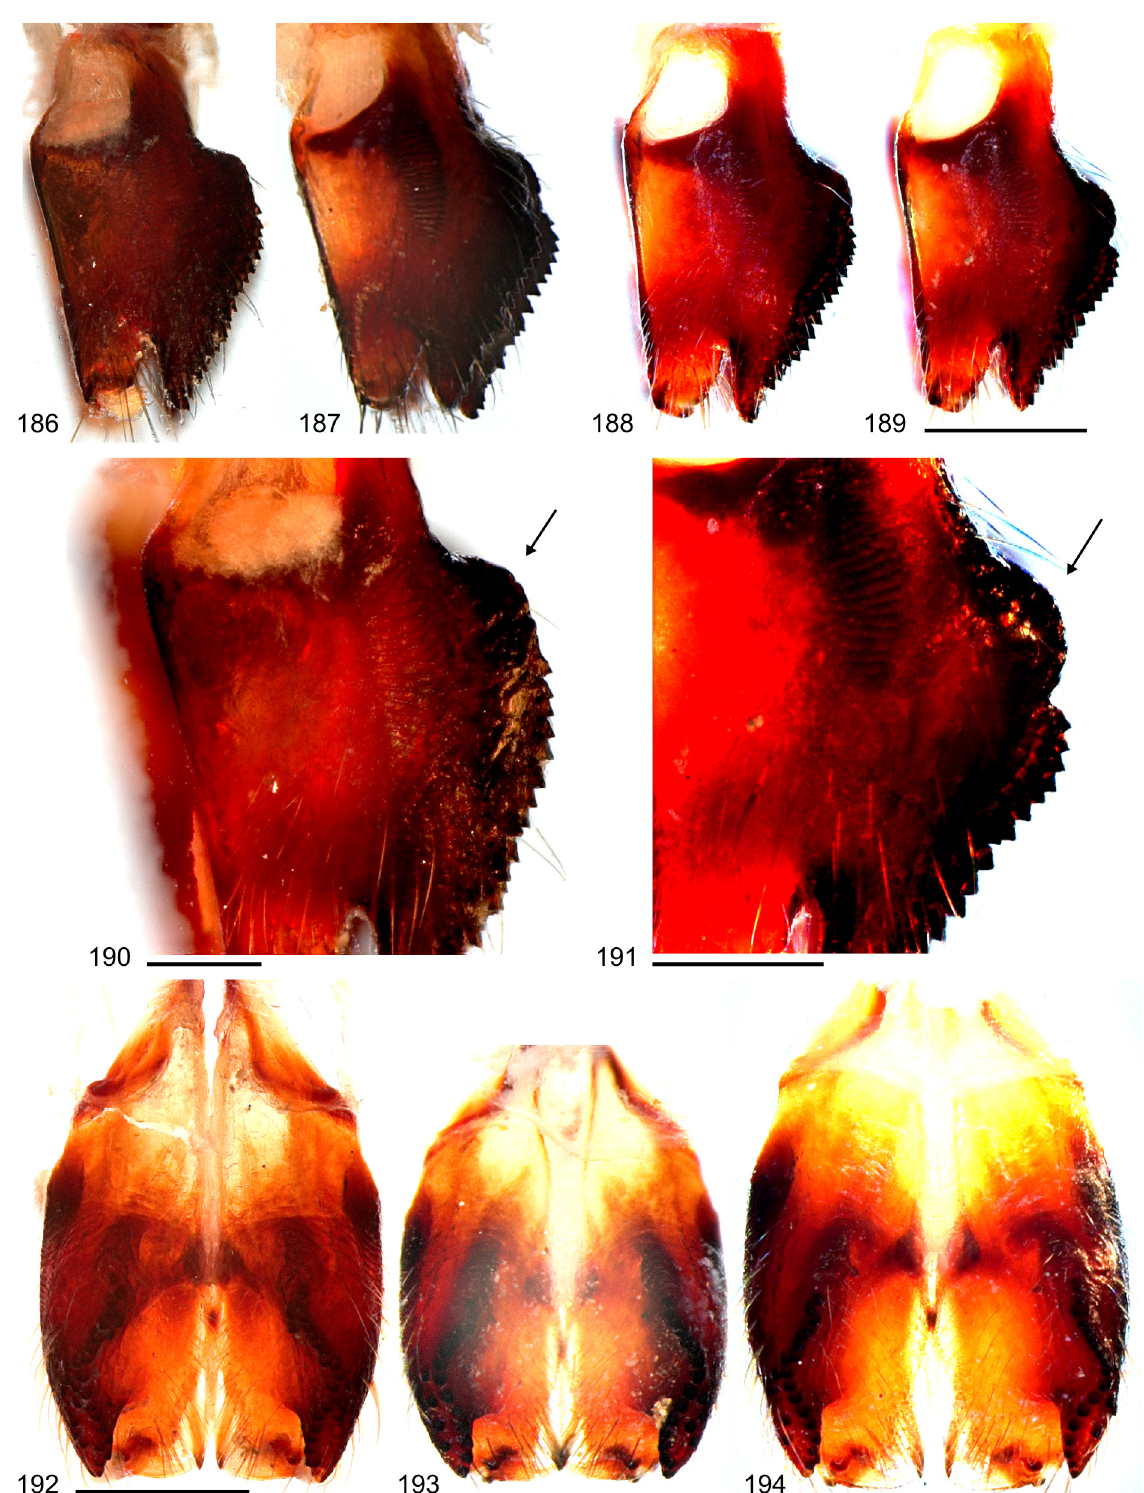
Figs 186–194. Artema sp. c, male chelicerae, lateral and frontal views. 186 , 190 , 192 . Pakistan Baluchistan Province, Quetta (ZMMU). 187 , 193 . India Rajastan, Durjana (SMF). 188–189 , 191 , 194 . Sudan, Khartoum (MRAC 121706). Arrows = robust projection proximally on frontal process. Scale lines: 186–189, 192–194 = 0.5 mm; 190 = 0.2 mm; 191 = 0.25